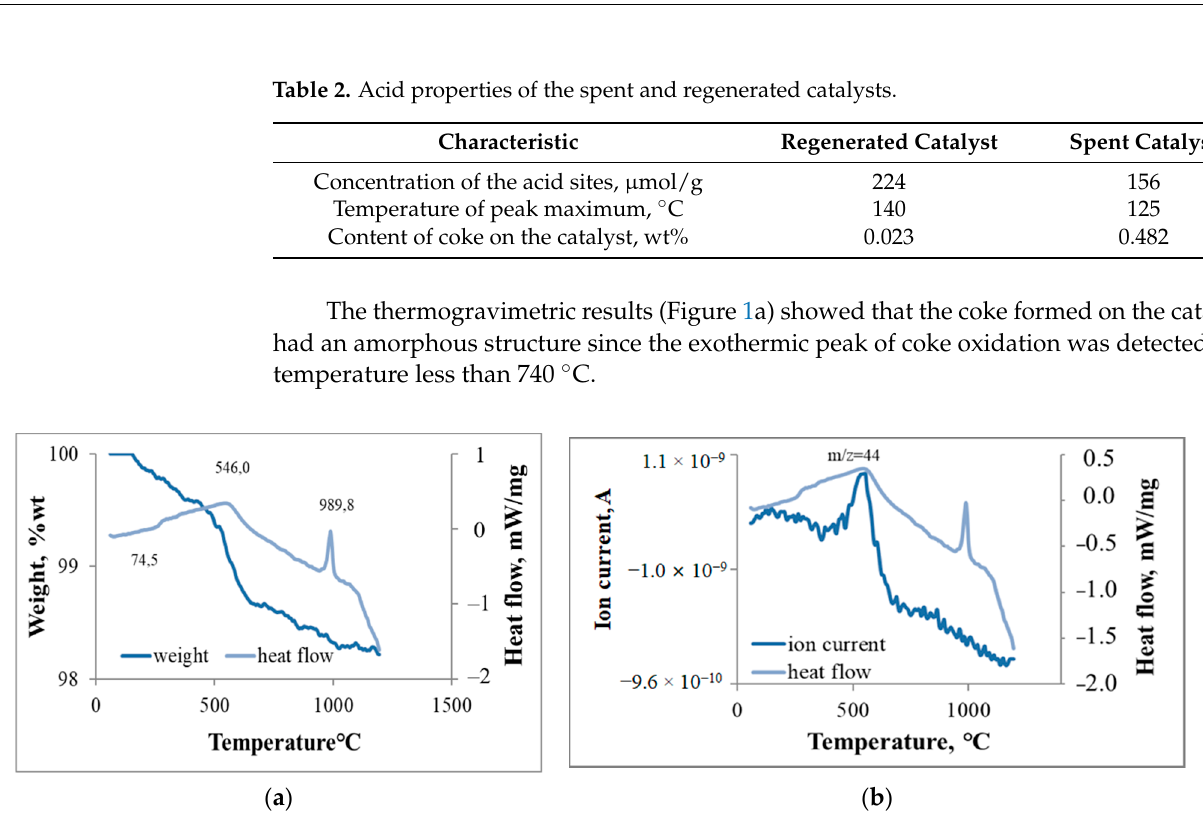
Figure 1. Thermogravimetry results: ( a ) thermogram for spent catalyst; ( b ) mass distribution.